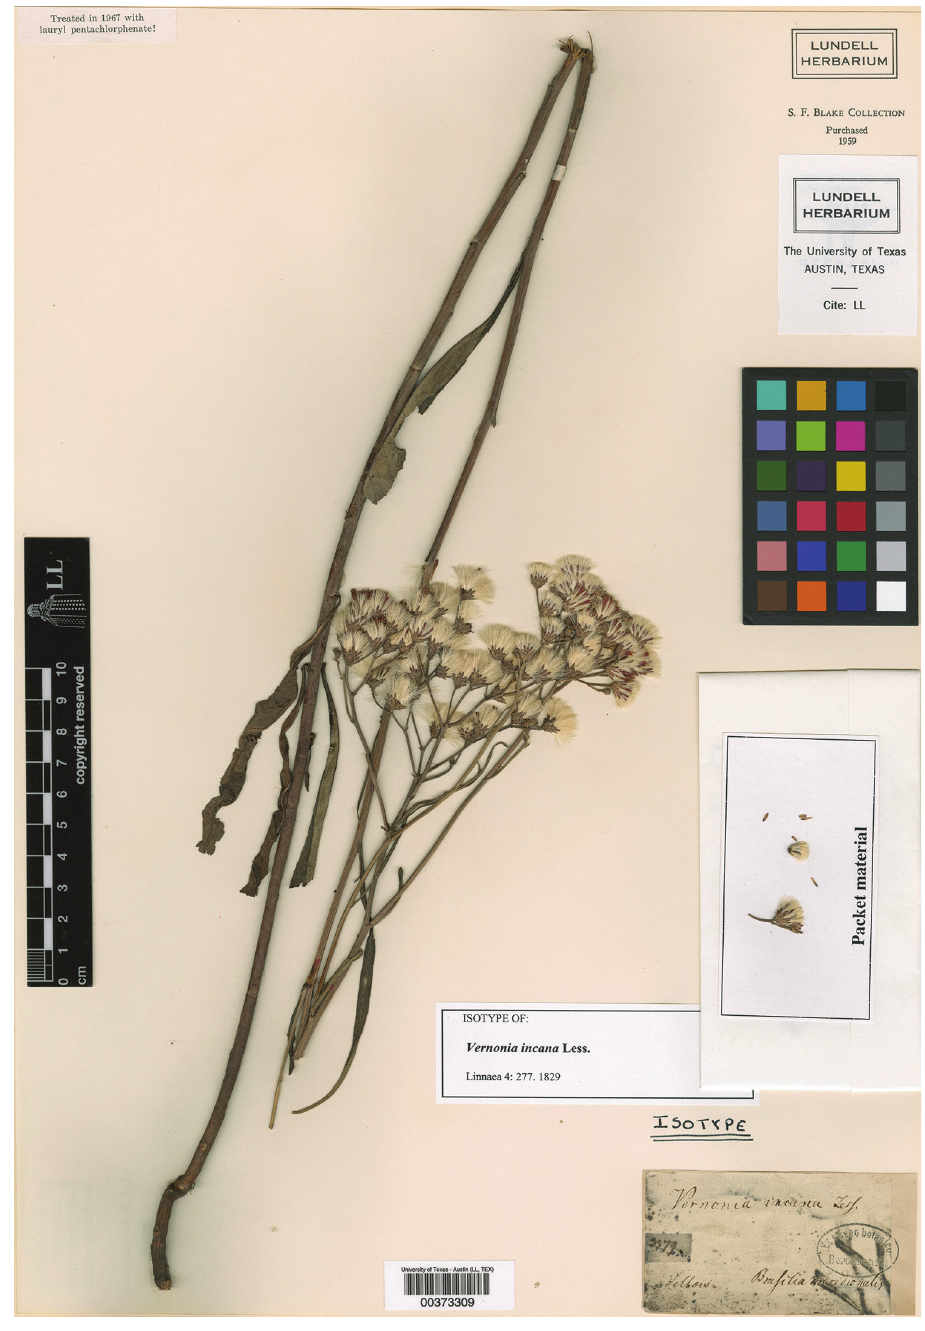
Figure 4. Image of the selected lectotype for Vernonia incana Less. There are now six isosyntypes in Europe- an herbaria: all the specimens are similar, but the LL specimen was selected as the lectotype because it had the most complete information, including the collecting number and the label indicates that it had been in the Berlin herbarium before it was sent to S.F. Blake. [photo courtesy of JSTOR-Plants, continuously